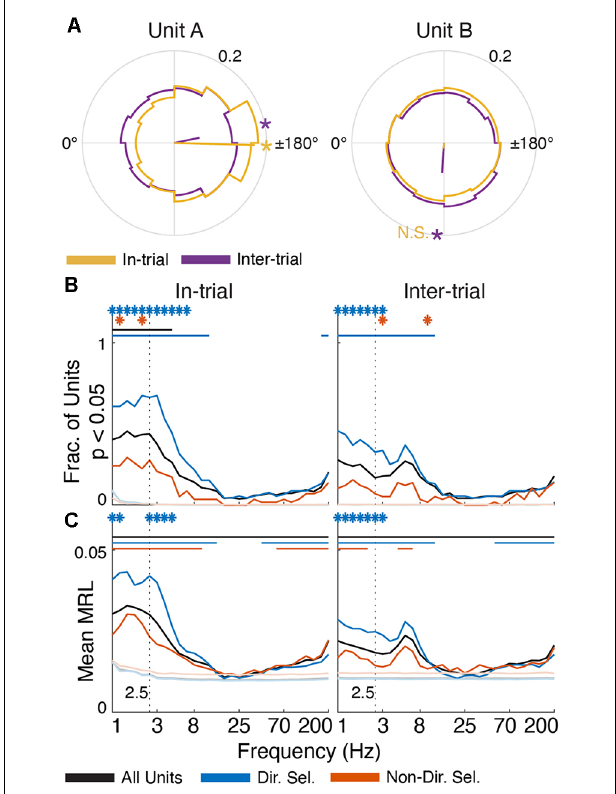
FIGURE 6 | Single unit activity is selectively entrained in low-frequency oscillations. (A) Polar histograms (12 bins) of spike-FP phase alignment at 2.5 Hz for in-trial (yellow) and inter-trial (purple) epochs for two directionally-selective units. Unit A is subtly but significantly entrained during both epochs (MRL = 0.17, p = 6.65 × 10 − 55 in-trial; MRL = 0.06, p = 3.32 × 10 − 6 inter-trial). Conversely, Unit B is only significantly entrained to 2.5 Hz oscillations during the inter-trial epoch (MRL = 0.06, p = 1.69 × 10 − 35 ) but not the in-trial epoch (MRL = 0.01, p = 0.08). Yellow/purple lines indicate the mean resultant vector (MRV) for each unit during each epoch. Asterisks on the outer circles indicate MRV orientation for epochs of significant entrainment (“N.S.” indicates MRV orientation for non-significant entrainment). (B) The fraction of units from each population (all units in black, directionally selective units in blue, and non-directionally selective units in red) that were significantly entrained to FP oscillations across frequencies ( p < 0.05, Rayleigh test for non-uniformity) during task engagement (“in-trial”) and the inter-trial interval (“inter-trial”). (C) Average MRL for each unit population across frequencies. The mean MRL for each population was significantly different from the surrogate spike trains at 2.5 Hz ( p < 0.001). In panels (B,C) asterisks indicate frequencies at which directionally selective and non-directionally selective unit entrainment is significantly different from all units ( p < 0.001). Solid lines indicate frequencies for which unit entrainment is significantly different from the firing-rate matched Poisson-distributed spike trains ( p <